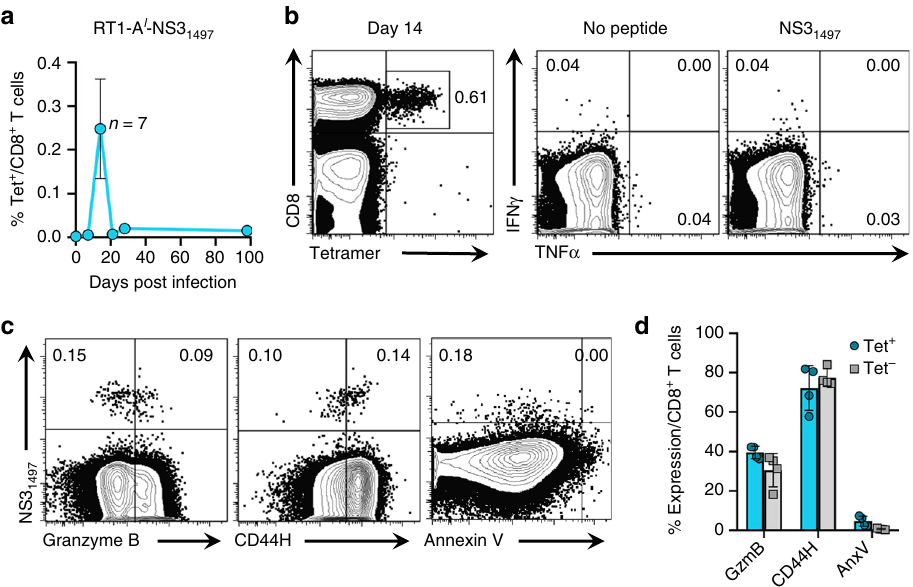
Fig. 2 Expansion of non-functional RHV-speci fi c CD8 + T cells during infection. Lewis rats were challenged intravenously with 10 6 genomes of RHV and intrahepatic CD8 + T cell responses to the RT1-A l -restricted NS3 1497 epitope were assessed by class I tetramer and cytokine production assays. a Frequency of intrahepatic CD8 + T cells speci fi c to NS3 1497 epitope at the indicated time post infection. Data from n = 3 – 7 rats per timepoint are shown (mean±SEM). b Sample fl ow plots showing frequency of intrahepatic NS3 1497 -speci fi c CD8 + T cells at day 14 when analyzed by tetramer staining (left) versus production of intracellular cytokines (right). For stimulation, cells were pulsed for 5-h with minimal peptide (10 µ g/mL). c Representative fl ow plots of intrahepatic CD8 + T cells stained with NS3 1497 tetramer and antibodies against granzyme B, CD44H, and annexin V at day 14. d Calculated frequencies of granzyme B (GzmB), CD44H, and Annexin V (AnxV) expressing cells within the tetramer (Tet) positive (blue circles) and negative (gray squares) CD8 + T cell populations 14 days post infection. Data from n = 4 rats are shown (mean ± SEM). Numbers within all FACS plots indicate the frequency of positive cells within the CD8 + T cell